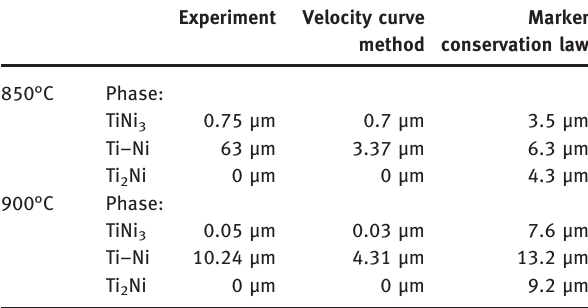
Table 2: The comparison of the Kirkendall plane positions in Ni – Ti alloy at 1,123 and 1,173 K from experiments and calculations (the position is calculated with respect to the phase